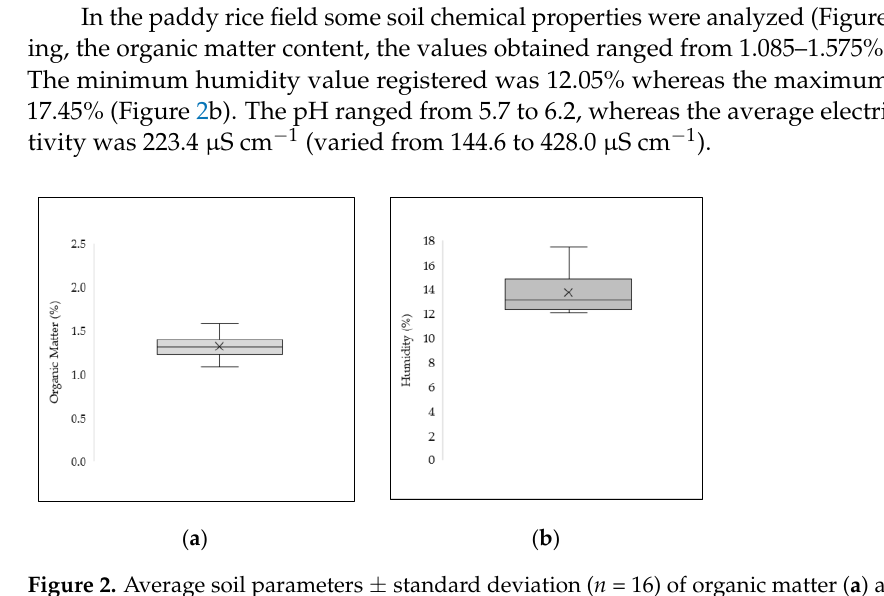
Figure 2. Average soil parameters ± standard deviation (n = 16) of organic matter ( a ) and humidity ( b ) of the paddy rice field.